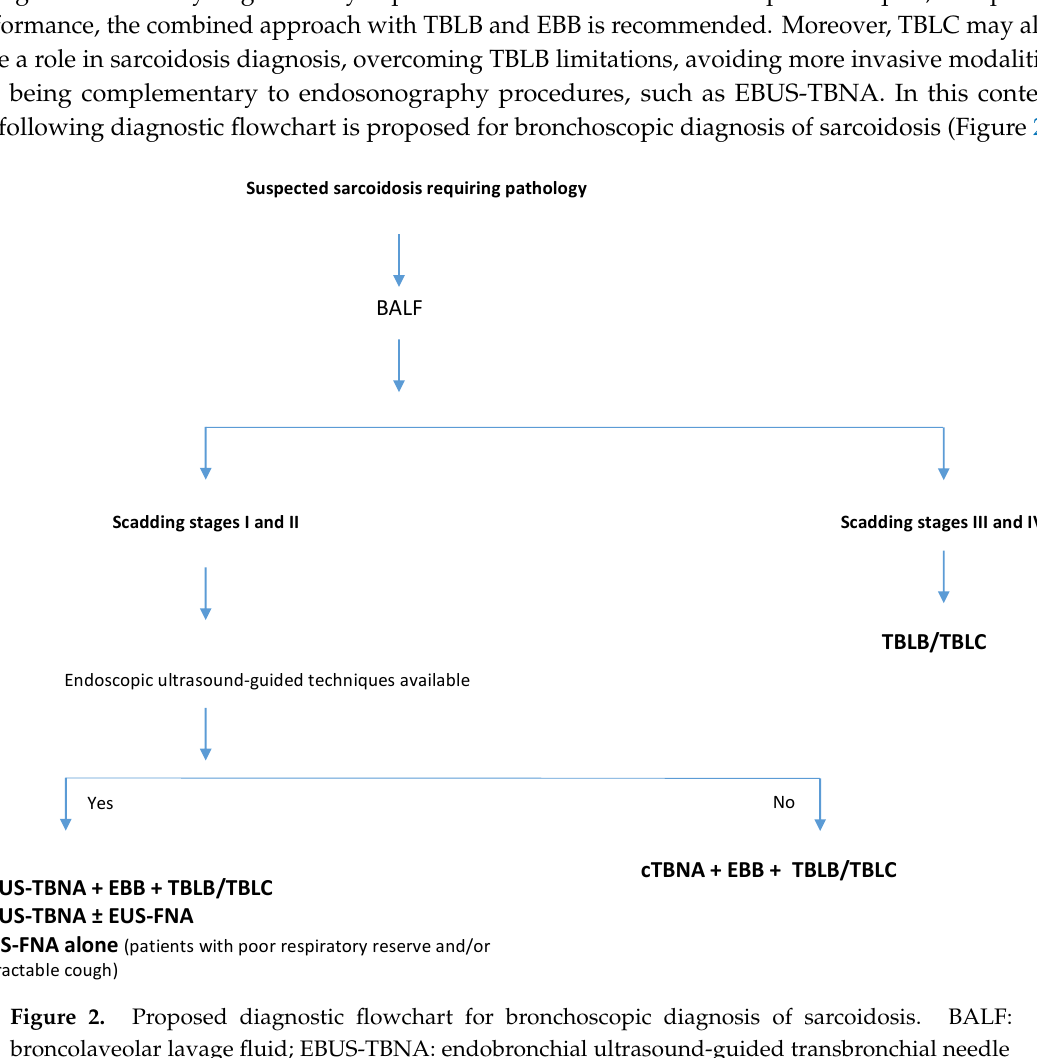
Fig 2. Proposed diagnostic flowchart for bronchoscopic diagnosis of sarcoidosis